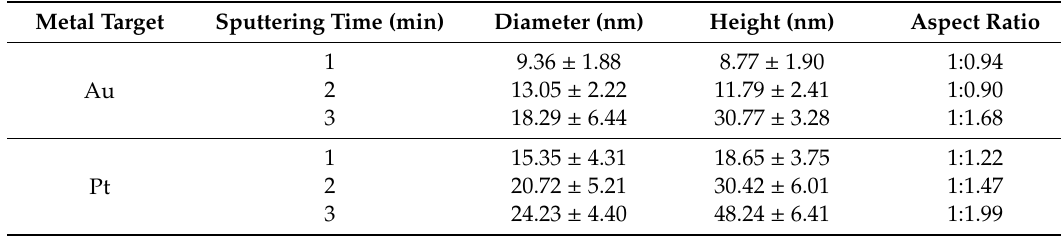
Figure 2. Diffuse UV–Vis–NIR spectra of ( a ) Au–TiO 2 NTs and ( b ) Pt–TiO 2 NTs after various sputtering periods.